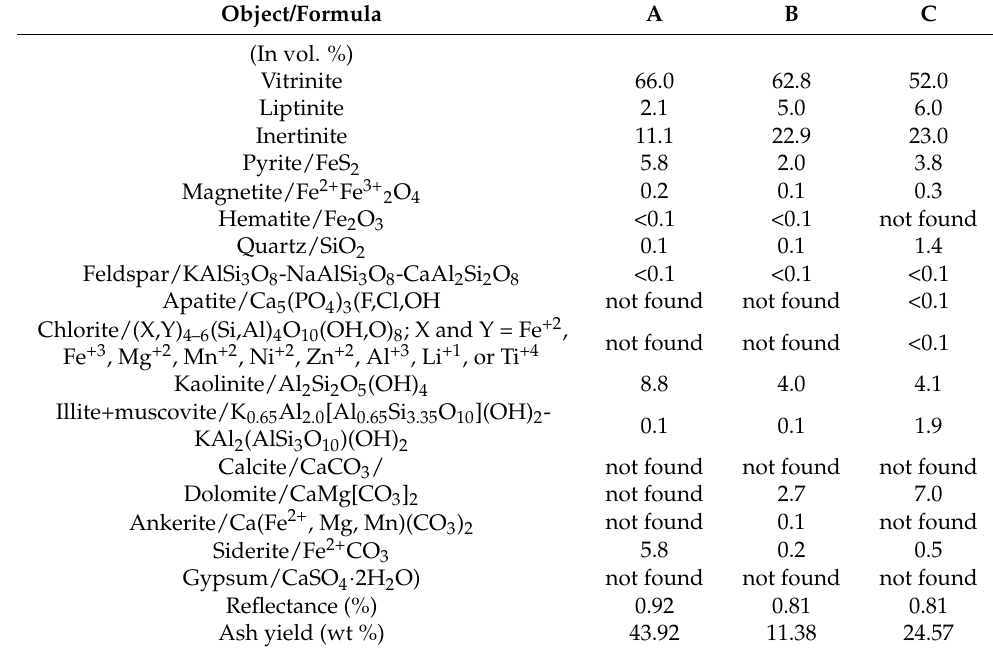
Table 1. Petrographic characteristics of the whole feed coal from the power plants